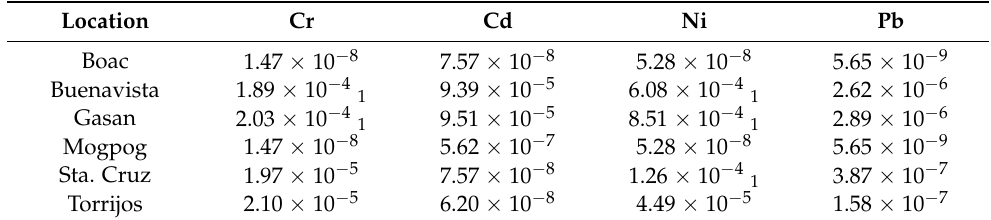
Table 6. Target cancer risk due to the consumption of vegetables with elevated heavy metal concen- trations.